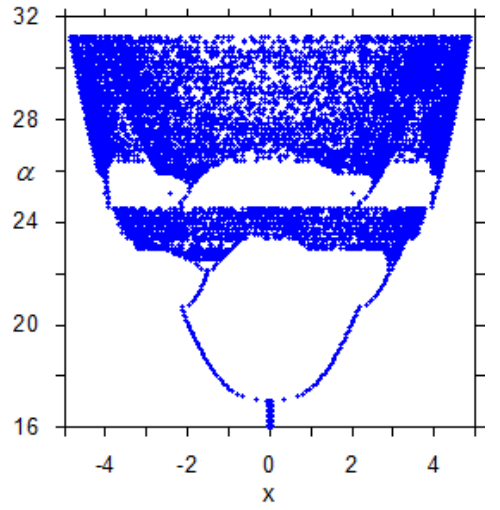
Fig. 7. Bifurcation diagram demonstrating modes of behavior of the system of Eq. (15) for ω = 2 π